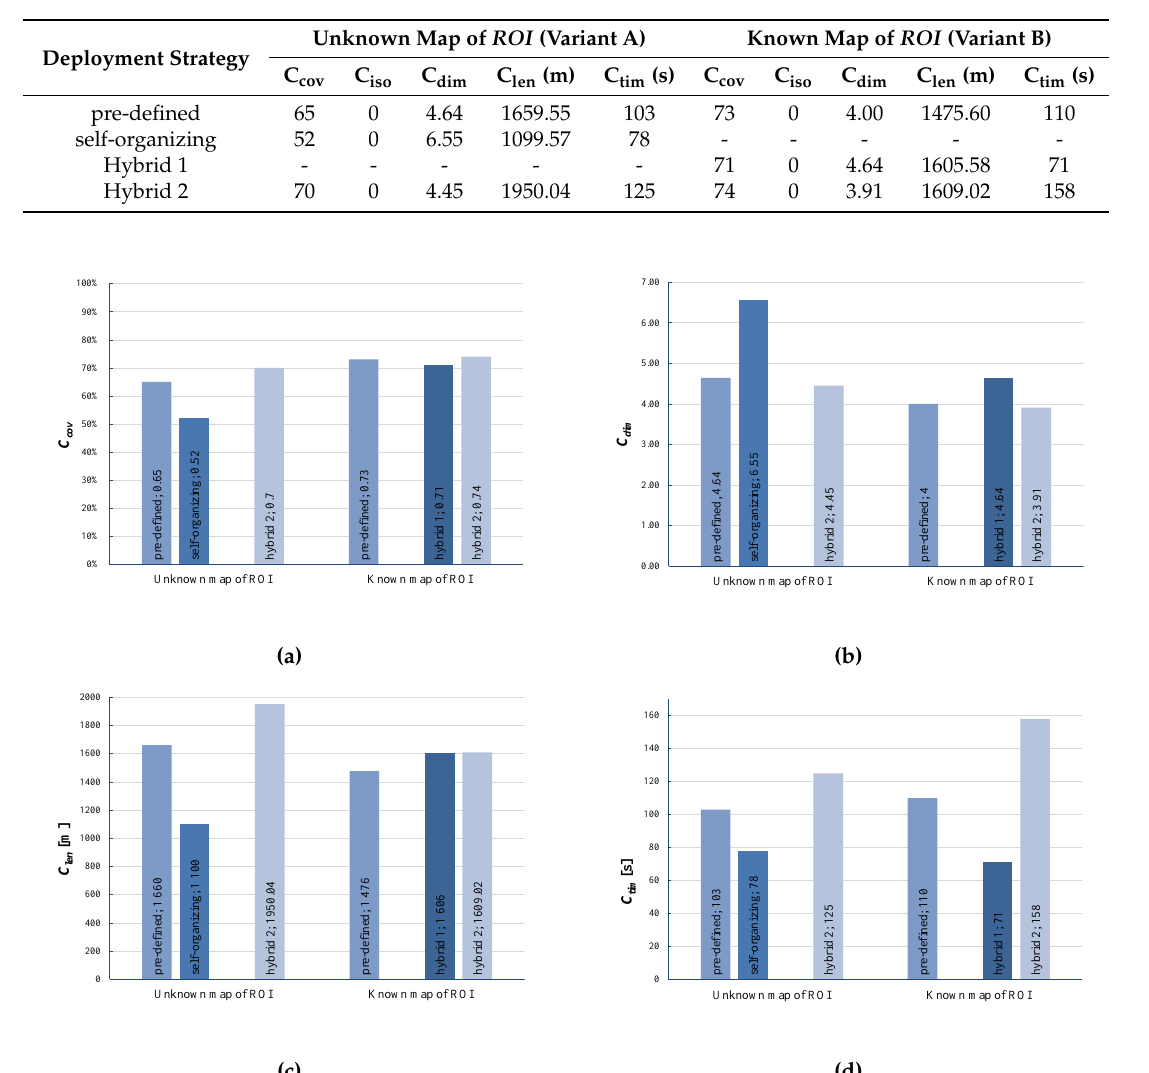
Table 1. Performance metrics for various deployment strategies, known and unknown map of ROI .